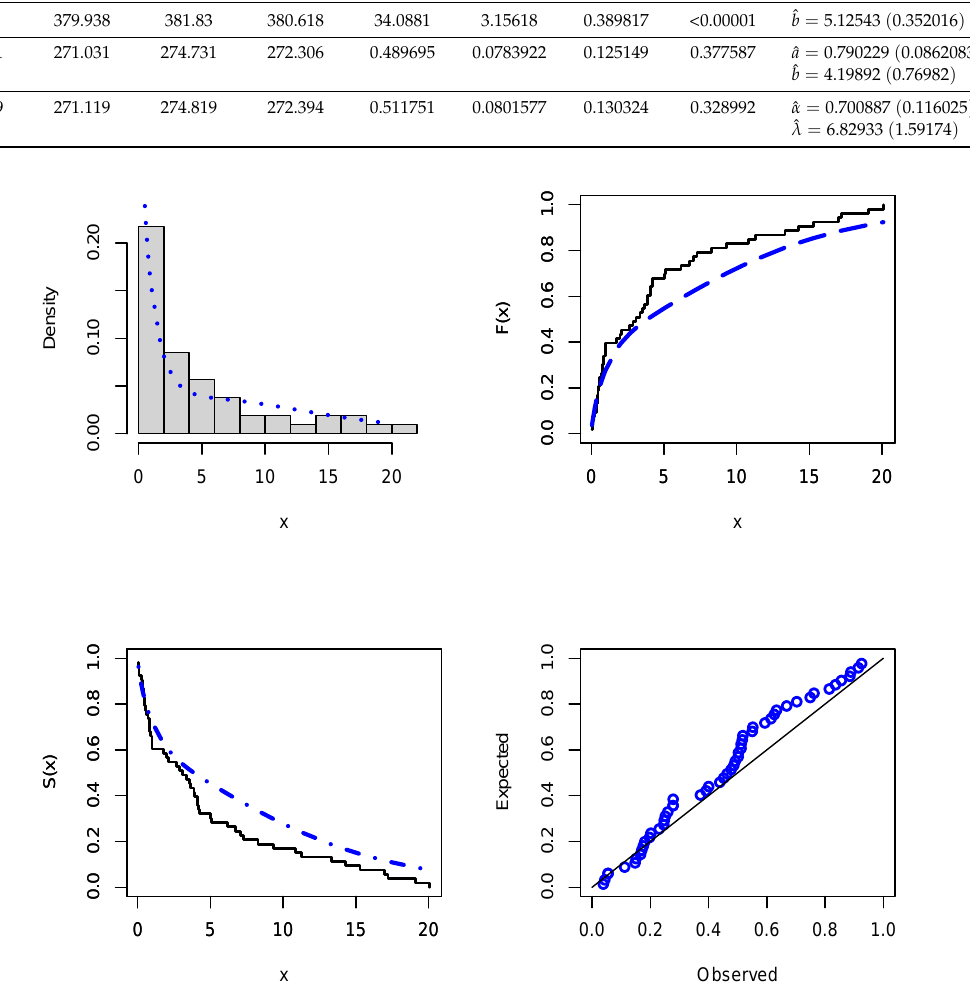
Figure 3. These figures show the histogram of the fitted PDF (top left), CDF (top right), SF (bottom left) and P-P (bottom right) plots of the COVID-19